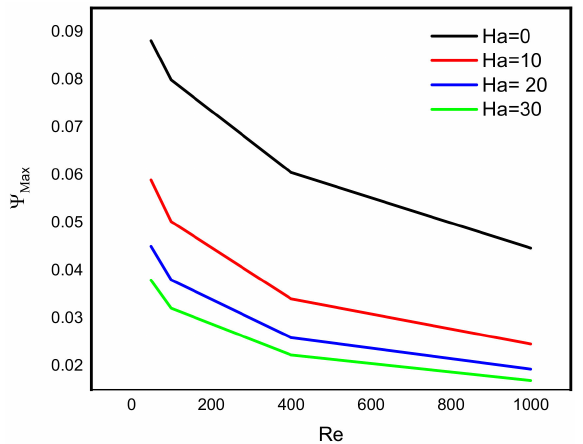
Figure 8. Variation in maximum stream function value with Reynold number at different levels of Hartmann